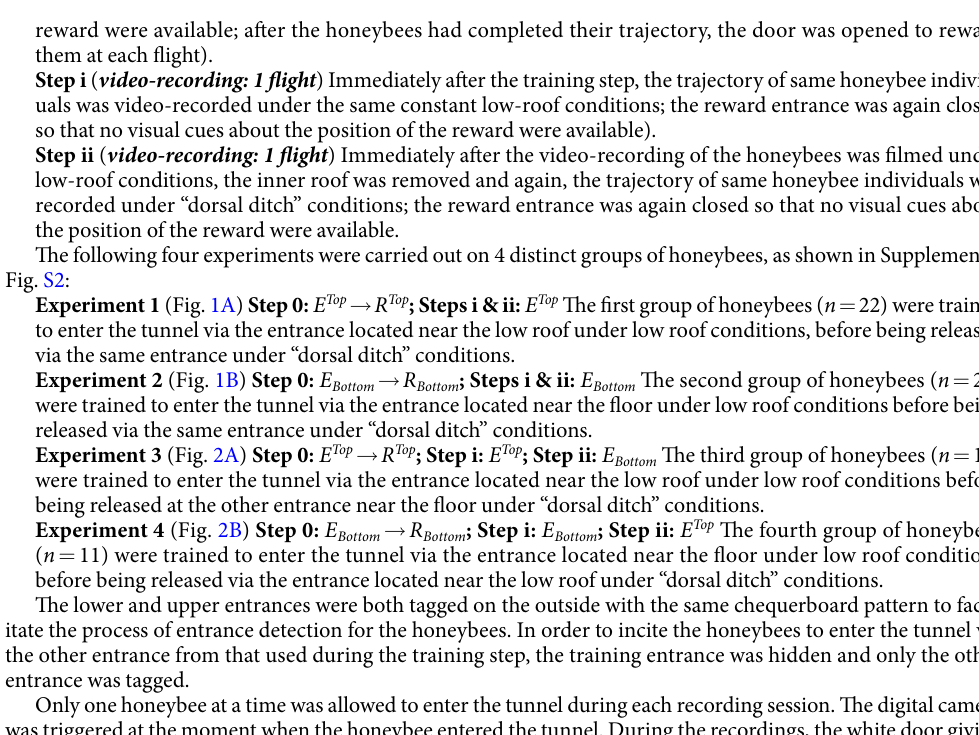
Fig. S2: Experiment 1 (Fig. 1A) Step 0: E Top → R Top ; Steps i & ii: E Top The first group of honeybees ( n = 22) were